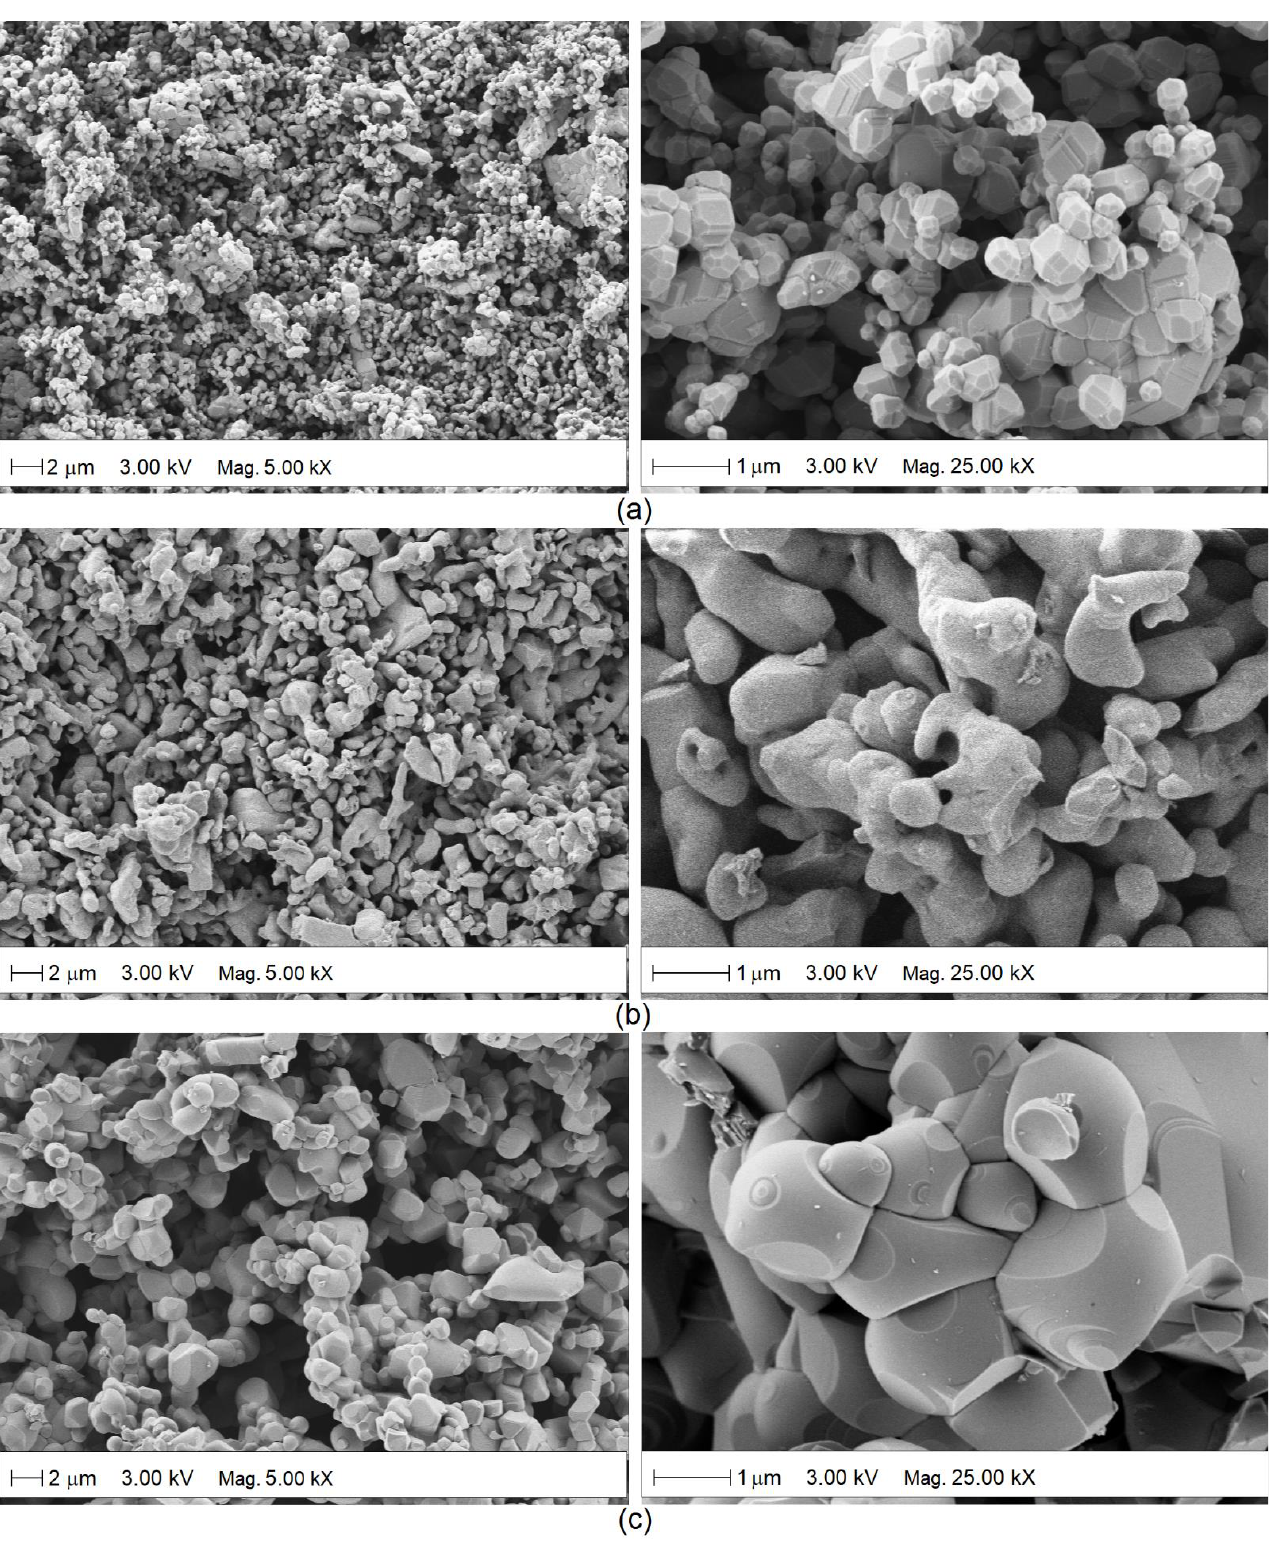
Figure 8. Surface morphology of the sensitive materials: ( a ) BaSnO 3 , ( b ) CaSnO 3 , and ( c ) ZnSnO 3 .